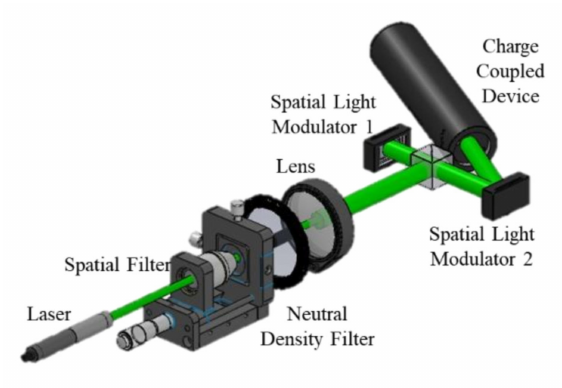
Figure 10. Schematic of optical